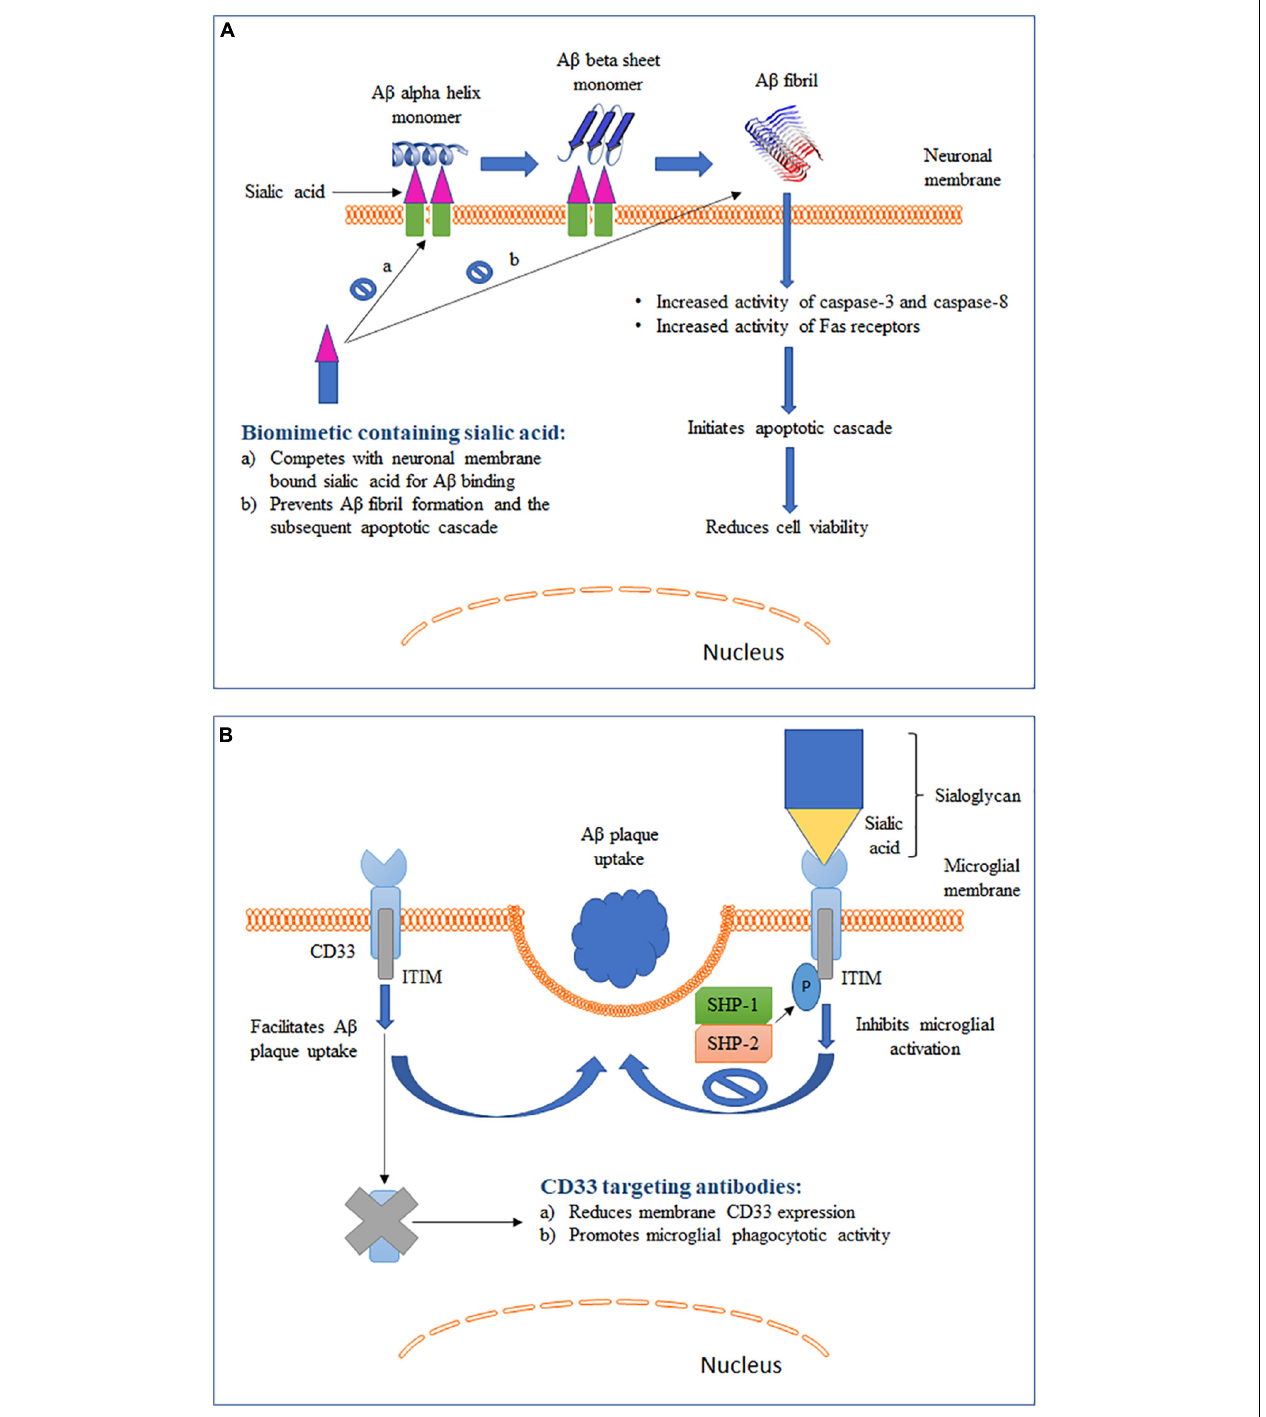
FIGURE 2 | Schematic representation of two different roles of sialic acid in AD pathology along with their therapeutic intervention strategies. (A) Role of sialic acid in A β fibrillation and the associated cytotoxicity. (B) Role of sialic acid in CD33-mediated microglial functions.